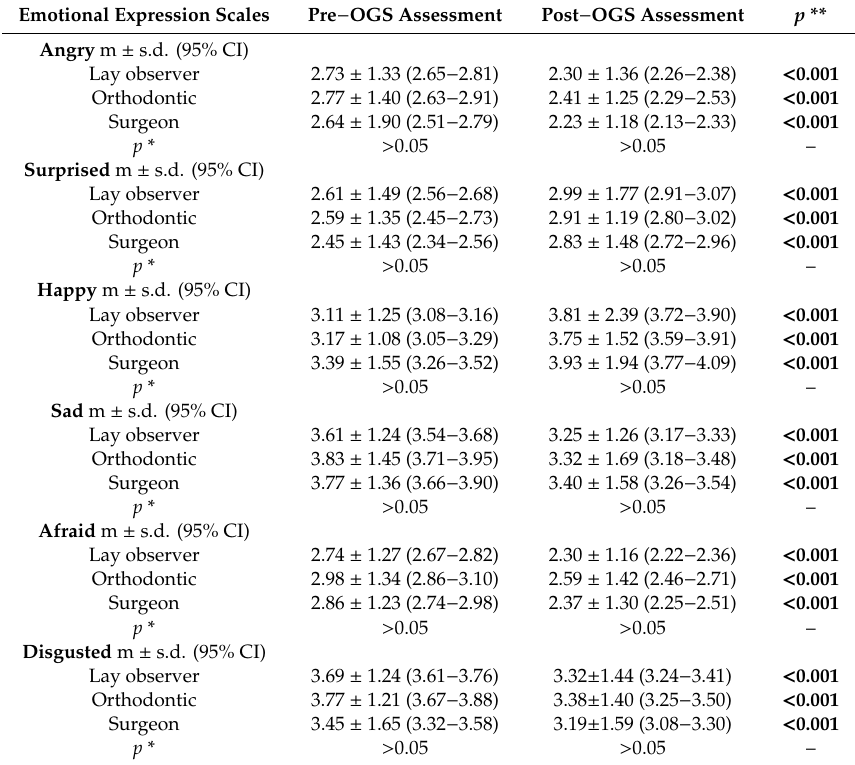
Bold values indicate statistical significance after Bonferroni correction. OGS, orthognathic surgery; m, mean; s.d., standard deviation; CI, confidence interval; p , p − value; –, not applicable; *, comparisons among the groups of raters; **, pre − OGS versus post − OGS scores